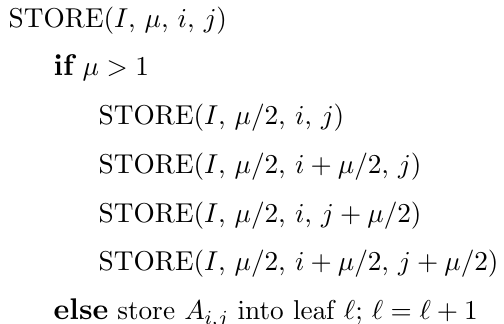
Figure 6. Storing the image into the leaves of the